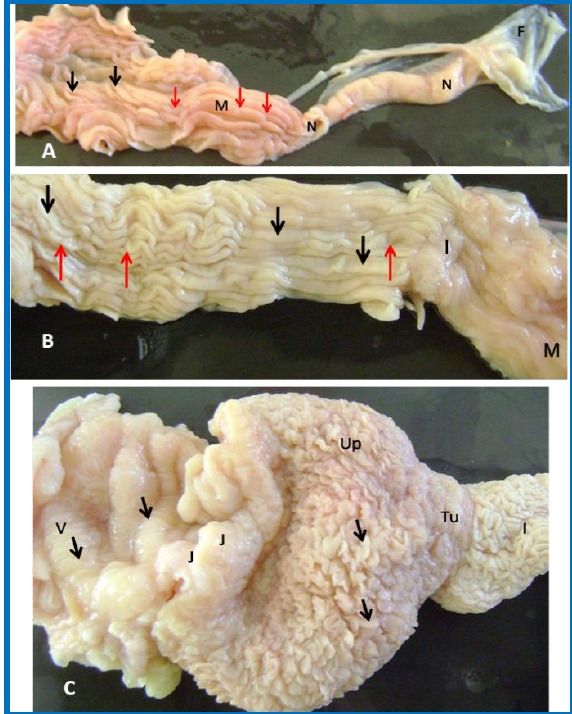
Figure, 6: Gross appearance of laying oviduct regions (24 weeks Mallard duck) shows: A. Theneck (N), funnel (F) magnum (M), mucosal folds (Black arrows), and indentations (Red arrows). B. The magnum (M), isthmus (I), mucosal folds (Black arrows), and indentations (Red arrows). C. The isthmus (I), tubular part of uterus (Tu), uterine pouch (Up), junction region (J), vagina (V). (Black arrows) mucosal